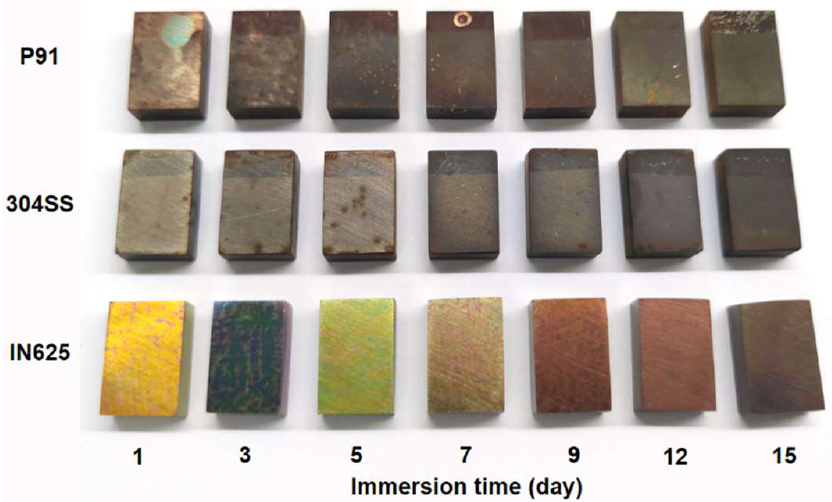
Figure 4. Macroscopic appearance of P91, 304SS, and IN625 alloys after 1, 3, 5, 7, 9, 12, and 15 days of exposure to Solar Salt at 565 °C.